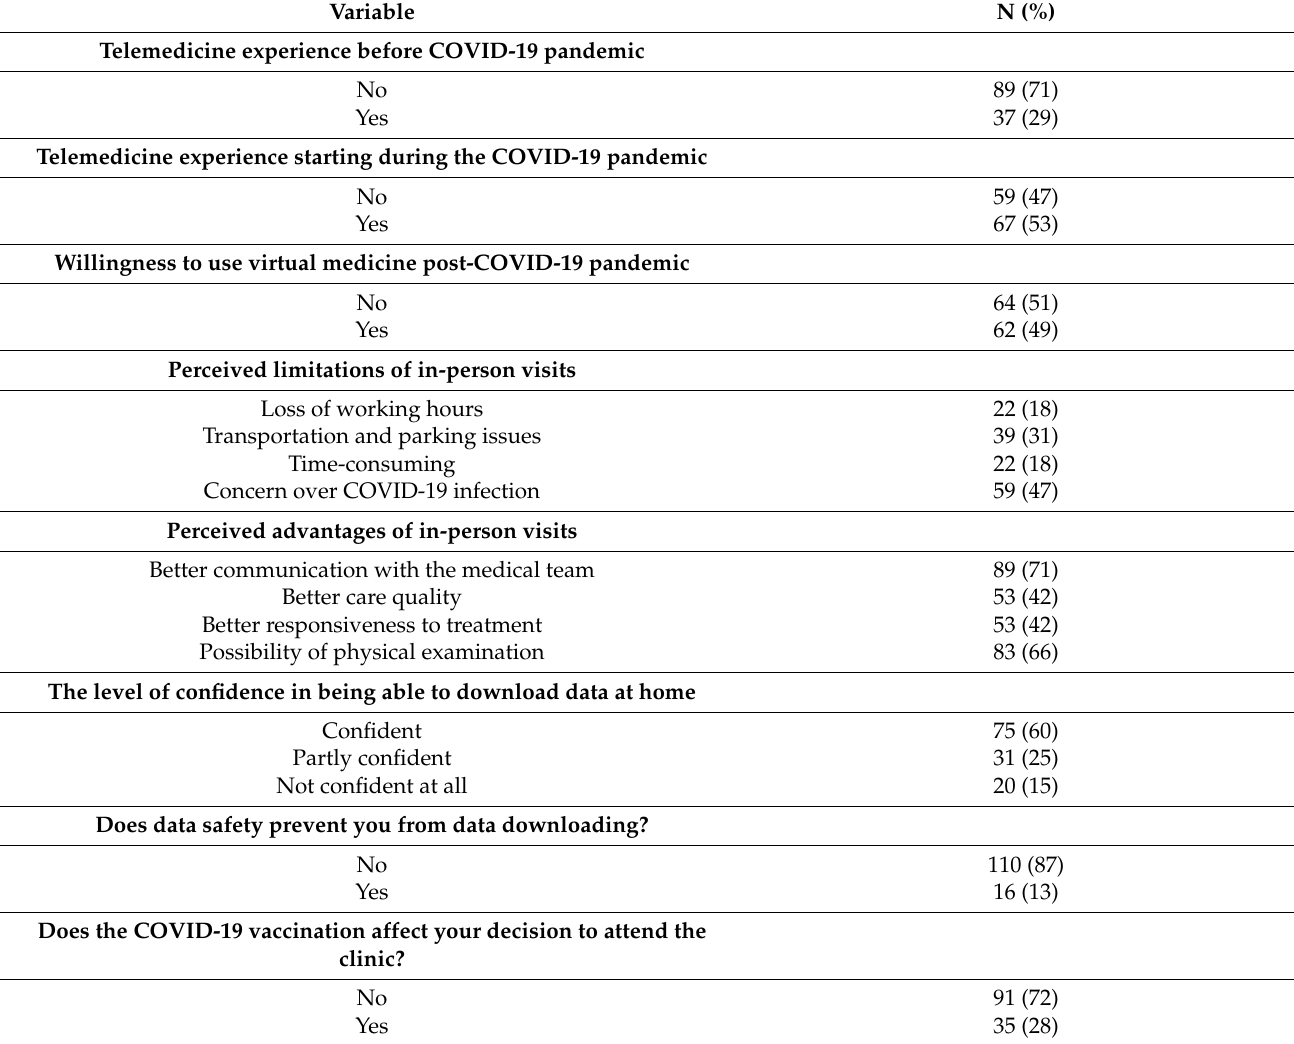
Table 2. Patients’ perceptions of virtual vs. in-person visits (N =